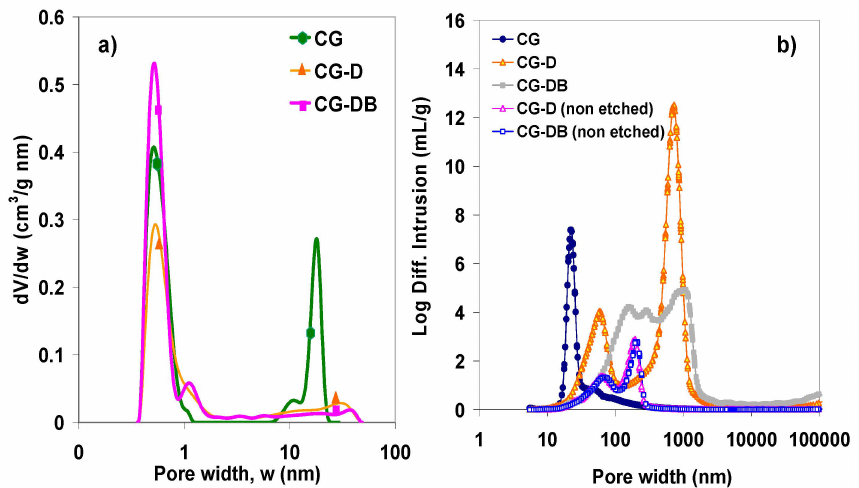
Figure 5. ( a ) Distribution of pore sizes of the carbon aerogels prepared in the presence of diatomite, after removal of the siliceous sacrificial additive obtained by the 2D-NLDFT method applied to the gas adsorption data; ( b ) Distribution of pore sizes in the macropore range obtained from mercury